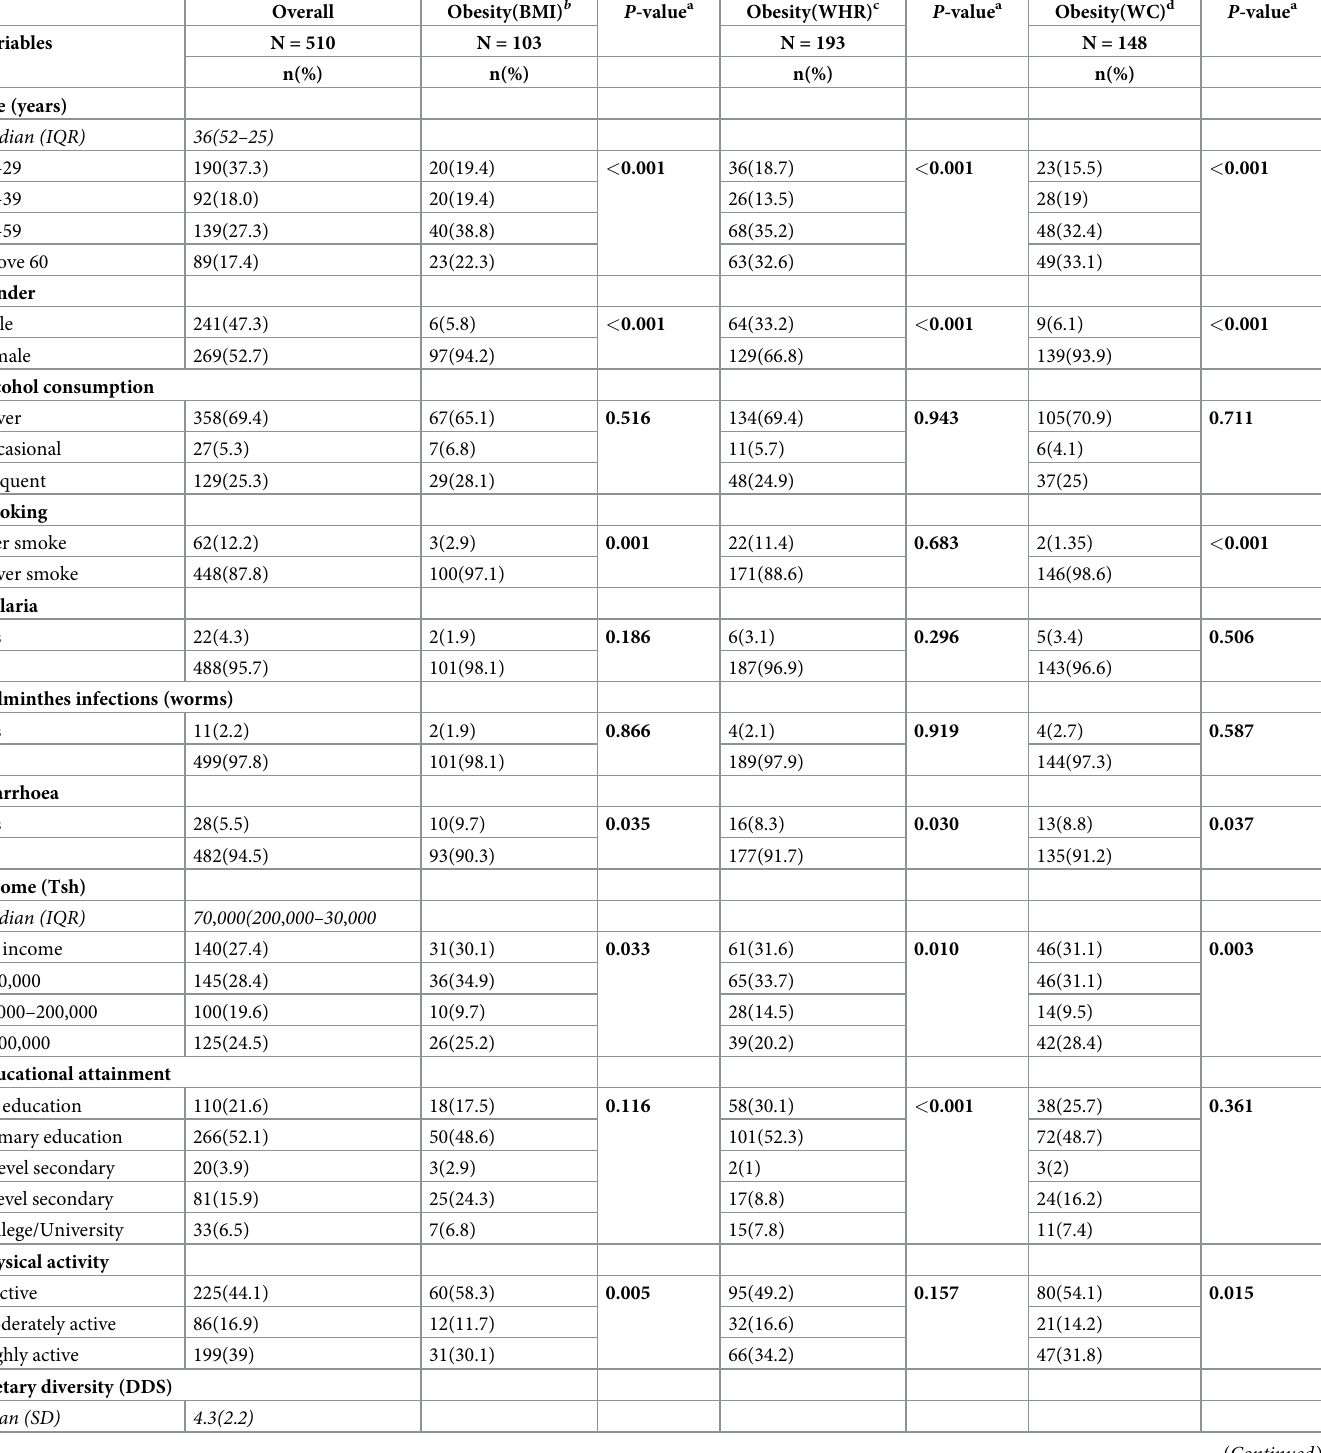
Table 1. Characteristics of the participants according to obesity measures in Monduli district, Tanzania ( N =